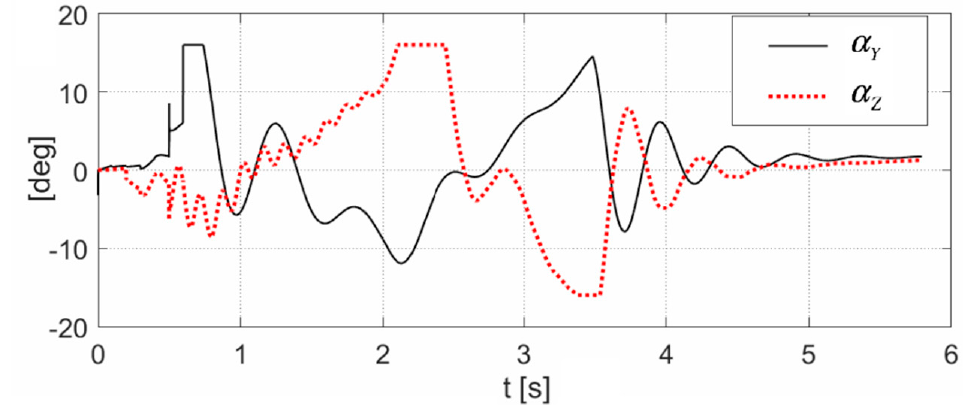
Figure 8. The performed angles of the flight control in the channel of altitude and direction.